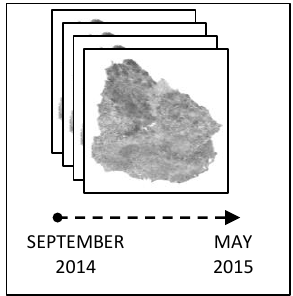
Figure 4. EVI MODIS stack for crop